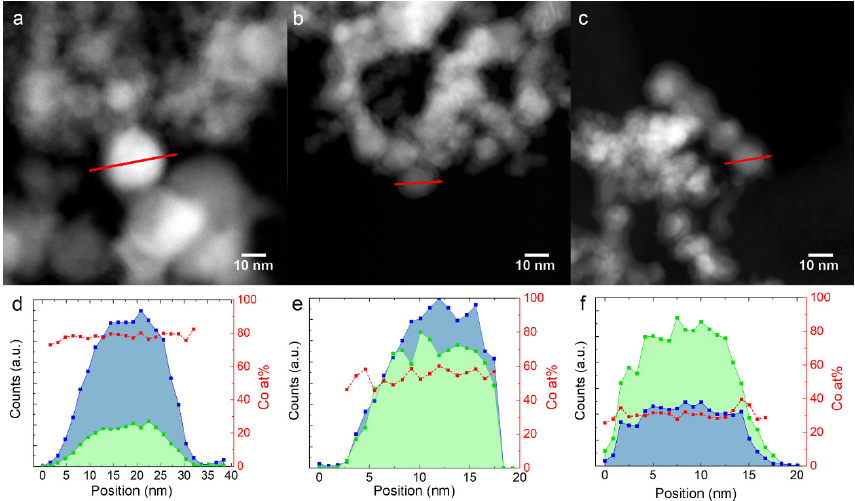
Figure 2. Fe and Co EDX composition profiles along the red arrow, shown in the STEM image above them. ( a , d ): 30Fe70Co; ( b , e ): 50Fe50Co; ( c , f ): 76Fe24Co. The blue and green profiles represent Co and Fe counts, respectively. Red squares represent the calculated Co atomic content. Table 1. Mean crystallite size 𝑑̅ and lattice parameter 𝑎 obtained from XRD analysis of metallic bcc reflections; Fe and Co content from EDX; BET-measured surface area 𝑆 (cid:3002)(cid:3003)(cid:3006)(cid:3021) ; surface area 𝑆 (cid:3002)(cid:3021)(cid:3006)(cid:3014) and volume-weighted mean diameter 𝑑̅ (cid:3021)(cid:3006)(cid:3014) calculated from TEM size distributions. The numbers in parenthesis represent the standard error in units of the last significant digit.